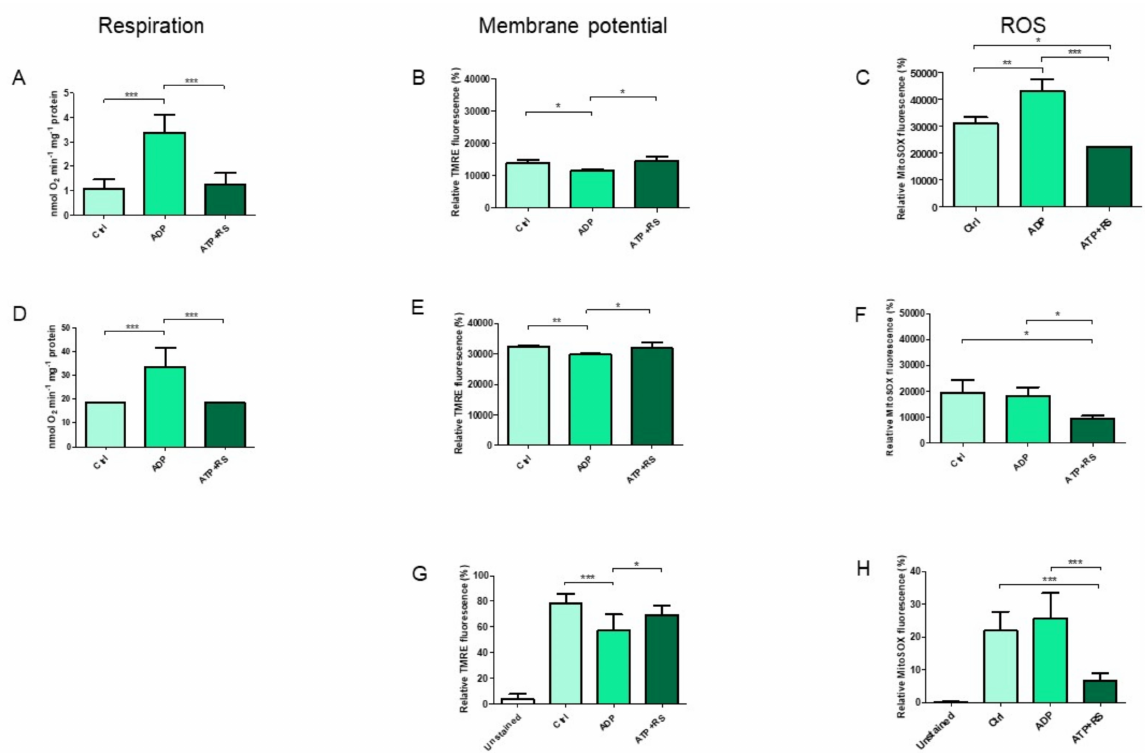
Figure 1. Correlation of mitochondrial respiration, membrane potential and ROS